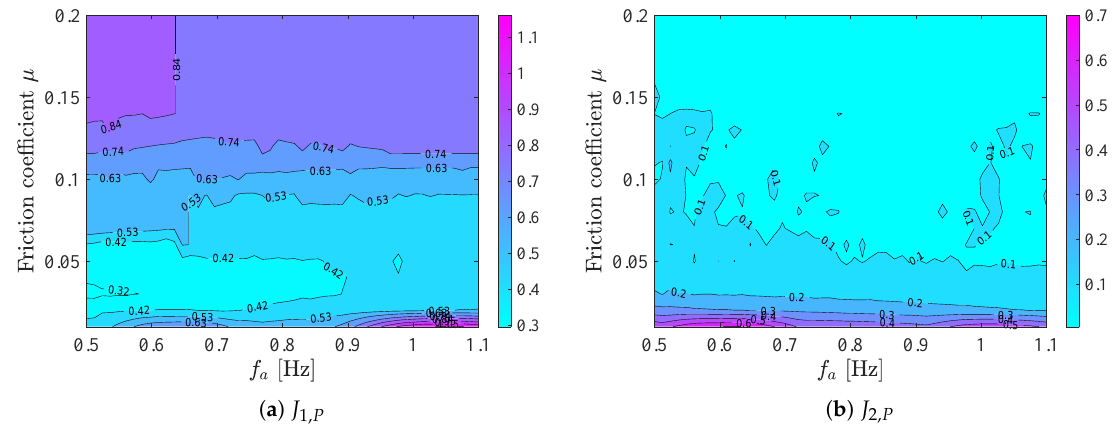
Figure 9. Sensitivity analyses. Response of the single FPS under the serviceability